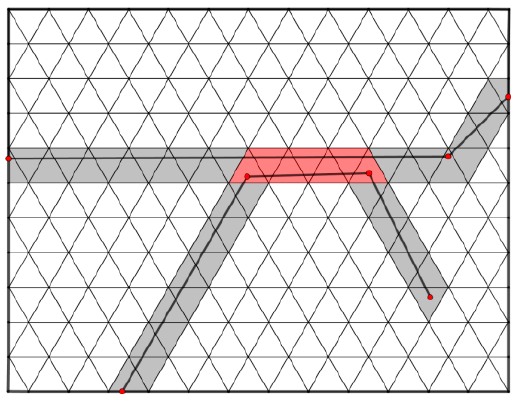
Figure 4. Change from disjoint to overlaps after gridding of line features.